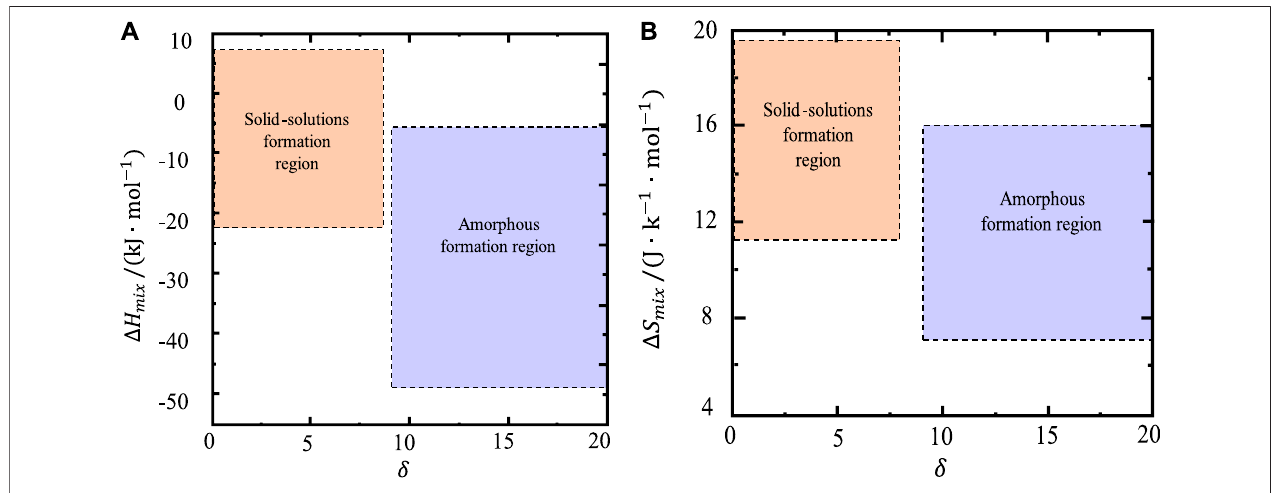
FIGURE 3 | (A) Δ Hmix — δ and (B) Δ Smix — δ plots showing the phase selection in high-entropy bulk metallic glass (HE-BMG) alloys (Li et al.,